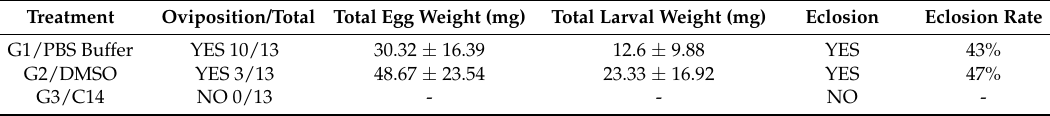
Table 3. Inhibitory effects of compound 14 on Rhipicephalus microplus fully engorged females. Injection of compound 14 into females treated during the artificial feeding procedure. Survival F = 126.9. p value <